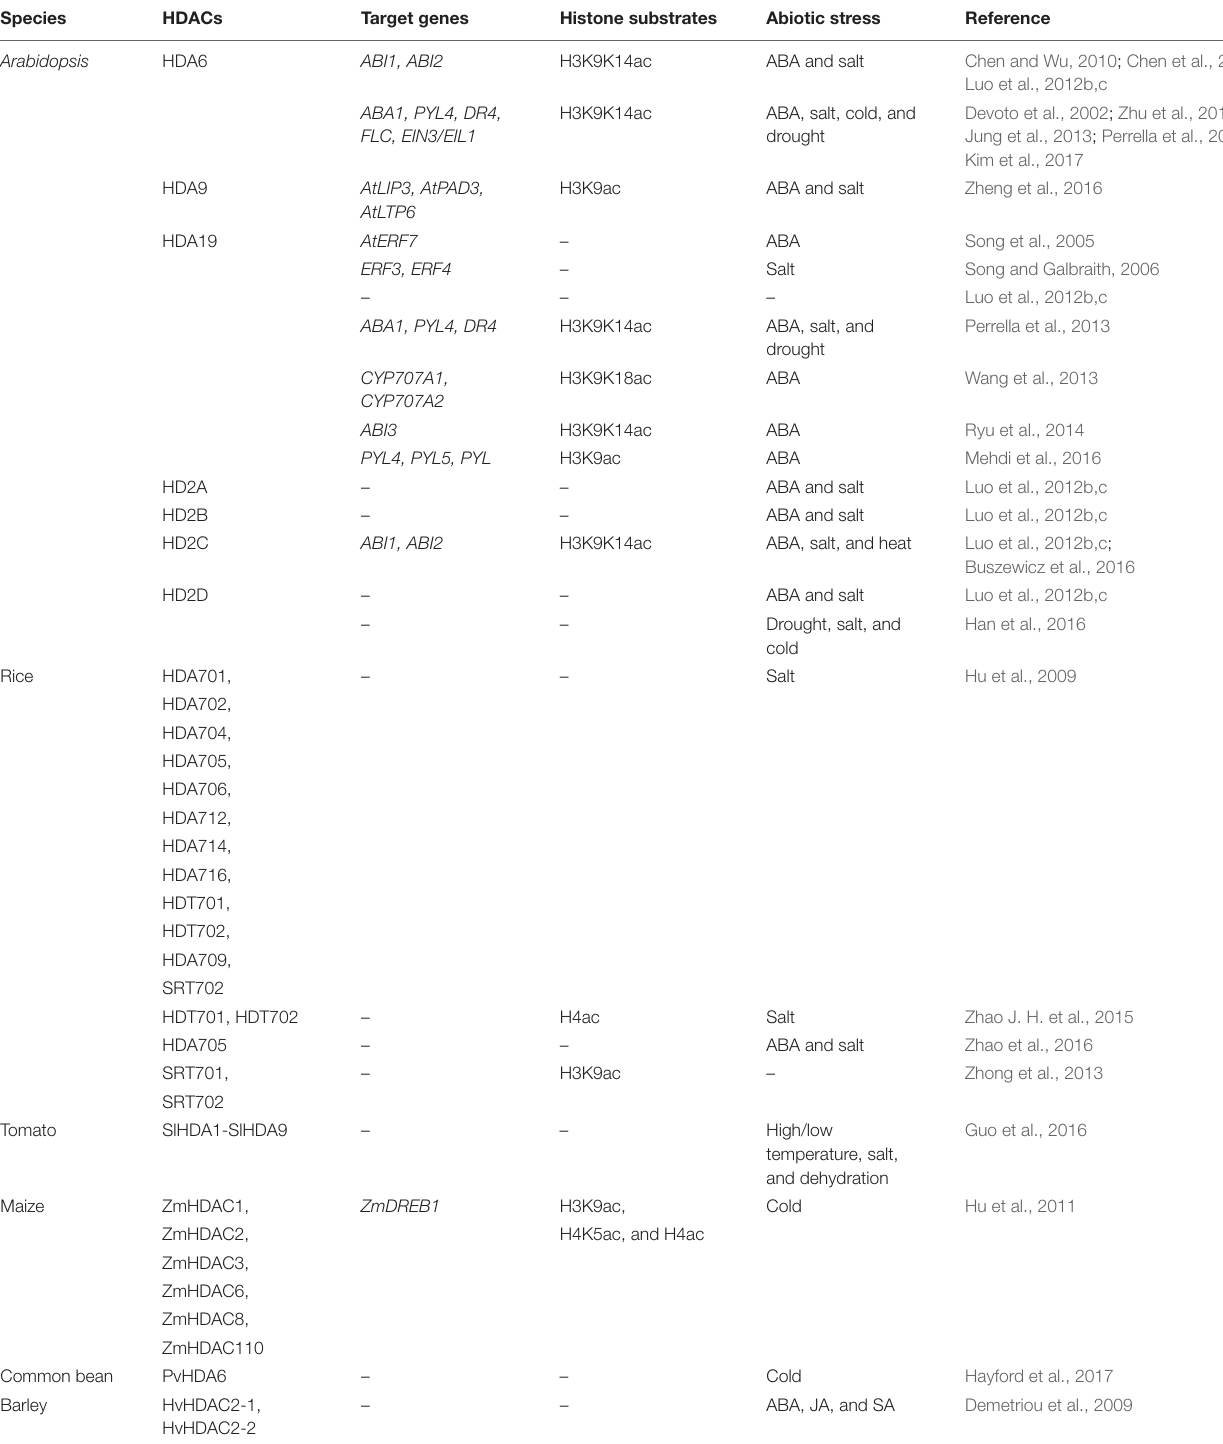
TABLE 1 | Plant HDACs in abiotic stress